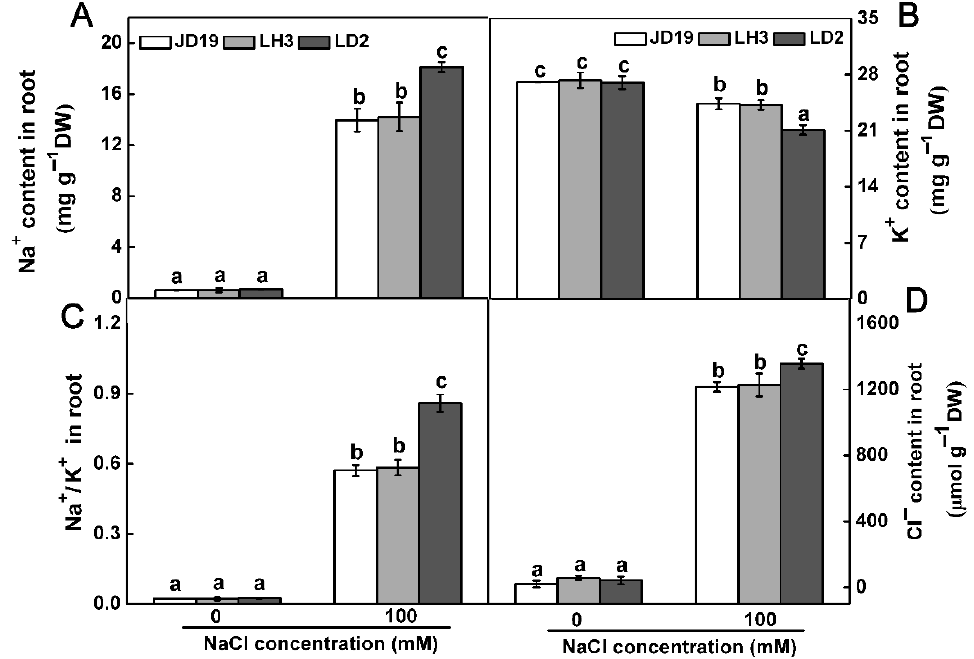
Figure 2. Na + content ( A ), K + content ( B ), Na + : K + ratio ( C ), and Cl - ( D ) content in roots of three soybean cultivars under 100 mM NaCl treatment. Data are the means ± SE (n = 3). Different letters indicate significant difference at p < 0.05.